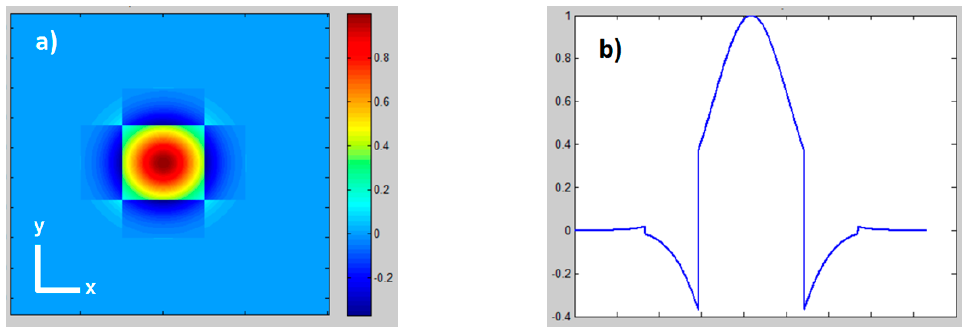
Figure 2. ( a ) Amplitude distribution of g fbs (x,y); ( b ) Line scan of amplitude distribution of g fbs (x,0), coordinate origin in the center.